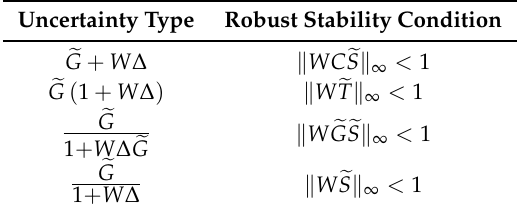
Table 1. Robust stability conditions for different uncertainties [32,34].